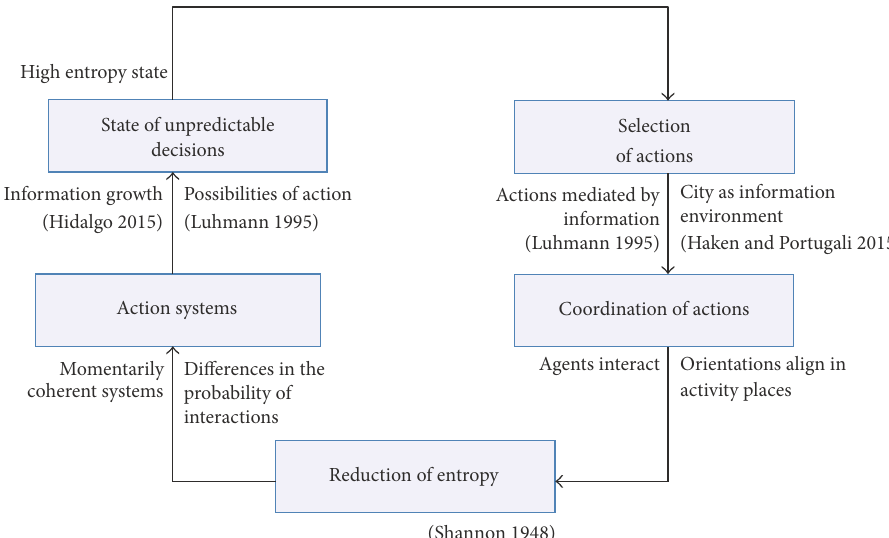
Figure 3: Recursive process that conducts interaction systems from chaotic states (high entropy) into coherence (low entropy).